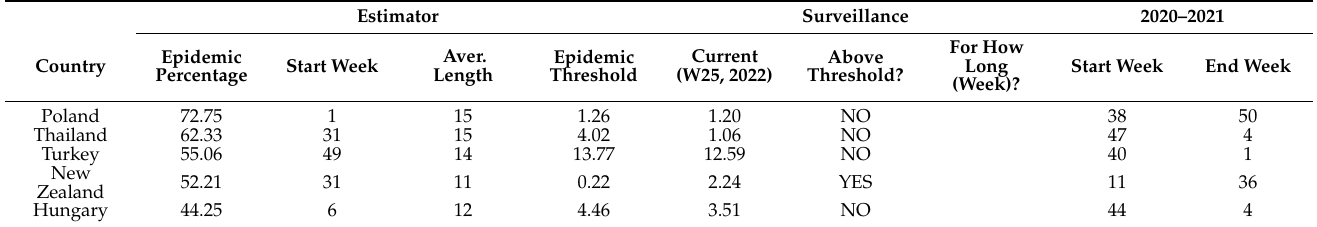
Figure 4. Google Trends of countries with limited surveillance: using the same keyword “RSV”, countries with clear patterns are listed on the ( left ). Countries without clear patterns are listed on the ( right ). Countries that are close to each other geographically are boxed in the same color. Table 2. MEM estimates for countries with limited surveillance for week 25, 2022: Estimates were based on Google Trends data between week 25, 2022 and previous 5 years, excluding 2020 and 2021 due to their abnormal intensified RSV activities. The upper part of the table contains countries listed on the left in Figure 4 with clear patterns. The lower part of the table contains countries listed on the right in Figure 4 with no clear patterns. Both parts are ranked by epidemic percentage, which is the ratio of cases during the epidemic to all